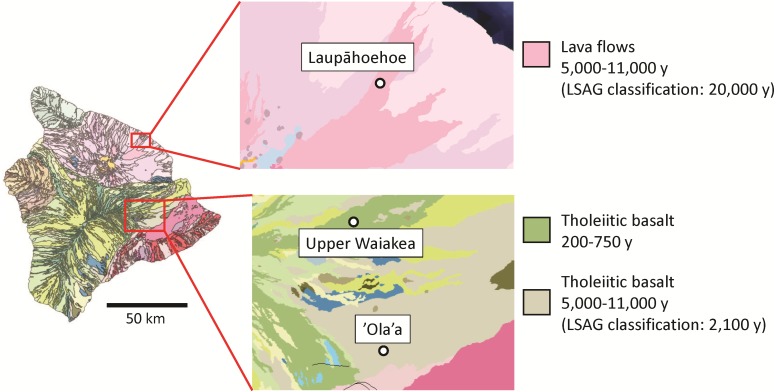
Map showing field sites where samples were collected.Colors represent geology and lava flow age, determined by United States Geological Survey (Sherrod et al., 2007). Where applicable, substrate age classifications determined by the Long Substrate Age Gradient (LSAG, Crews et al., 1995) are included.